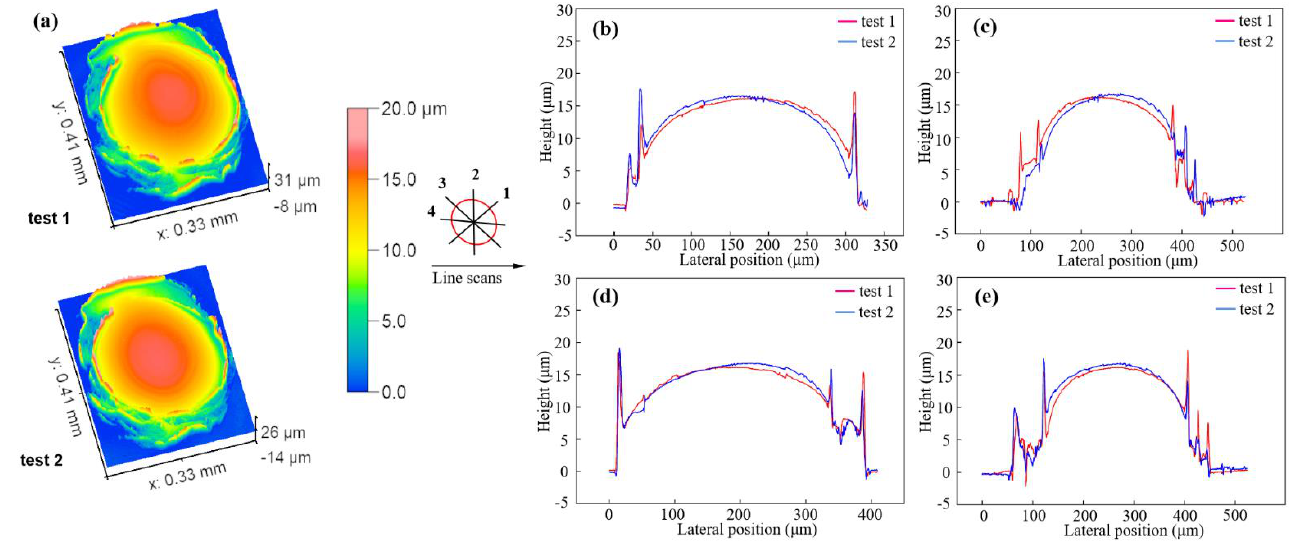
Figure 6. ( a ) Surface topography and ( b ) surface profiles 1, ( c ) surface profiles 2, ( d ) surface profiles 3 and ( e ) surface profiles 4 of embossed glass microlenses in the repeating experiments.